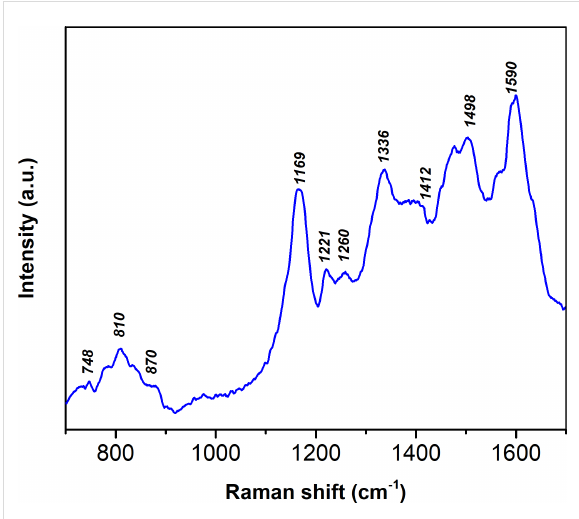
Figure 2: The Raman spectra of the